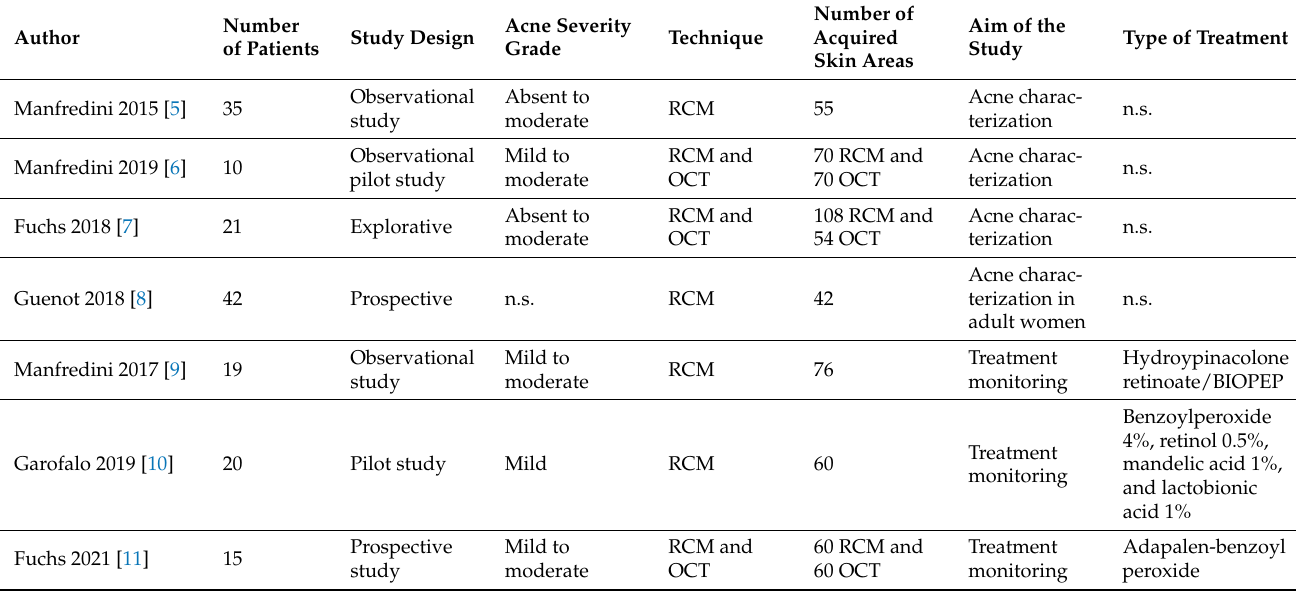
Table 2. Data collection synthesis. (n.s.,